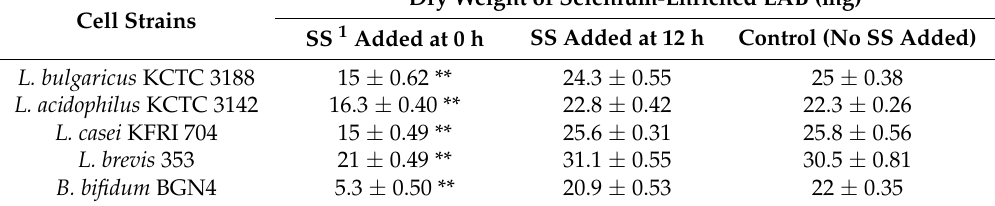
Table 1. Dry weight of selenium-enriched microorganism grown in de Man, Rogosa and Sharpe (MRS) containing 1 mM (172.9 mg/L) of sodium selenite. Data is shown as the mean ± SD of the triplicate